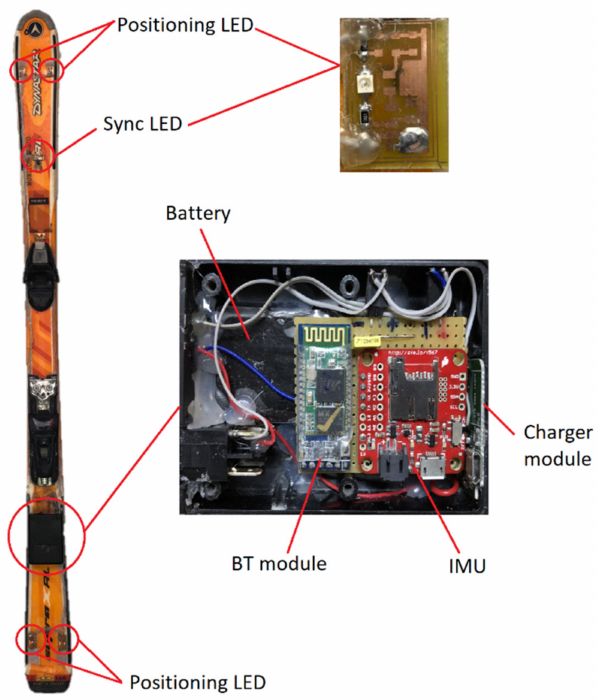
Figure 3. Developed system showing a photo of the ski with the 4-positioning light-emitting diodes (LEDs), an LED for synchronization, and the small waterproof box including the inertial measurement unit (IMU) board, the Bluetooth (BT) module, and the rechargeable